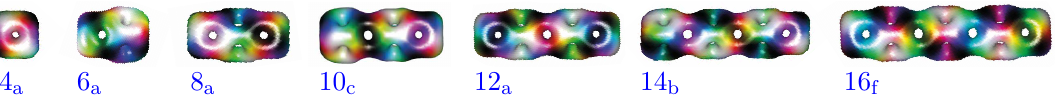
Figure 4. Straight chain Skyrmions from B = 4 to B = 16 .